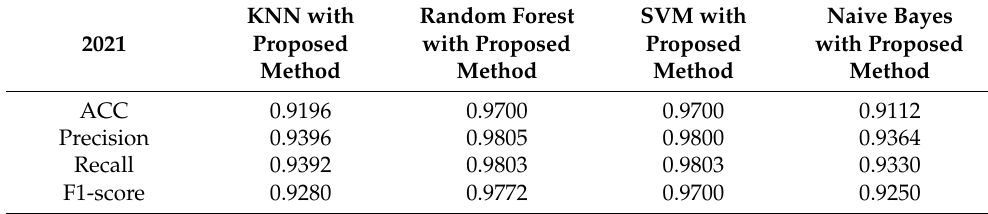
Table 3. Results from complex forecasting models for sequential feature extraction from data for 2021.